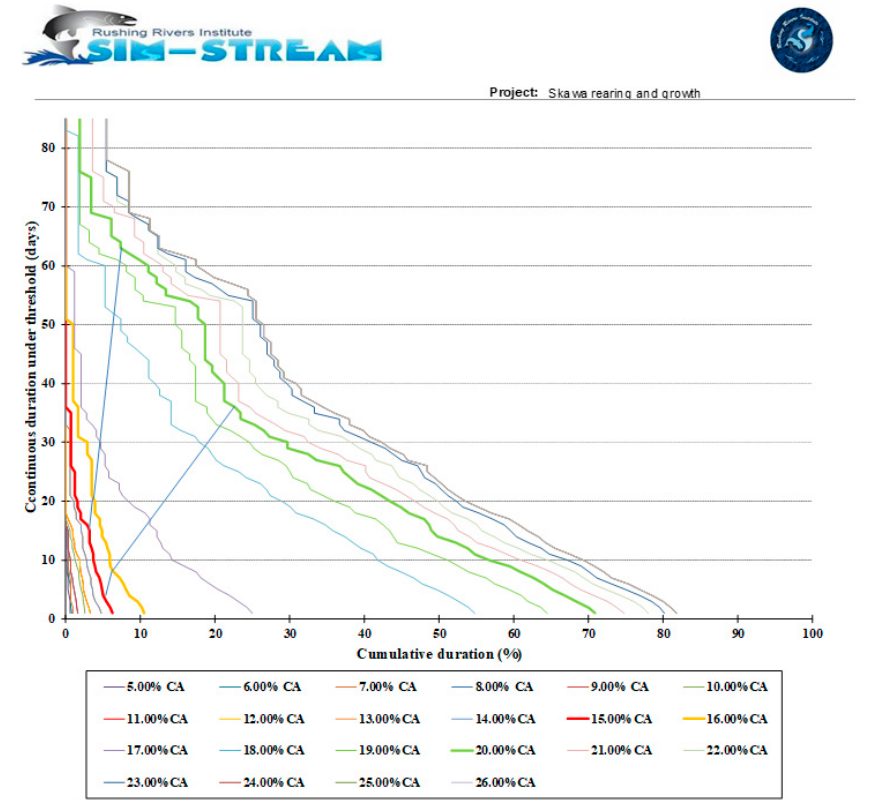
Figure 8. UCUT curves for fish communities present during the rearing bioperiod. Table 3. The eflow criteria calculated for the Skawa River; CA—Channel Area, I–XII—month. Spring Rearing and Fall Spawning/ Bioperiod Overwintering Overwintering Spawning Growth